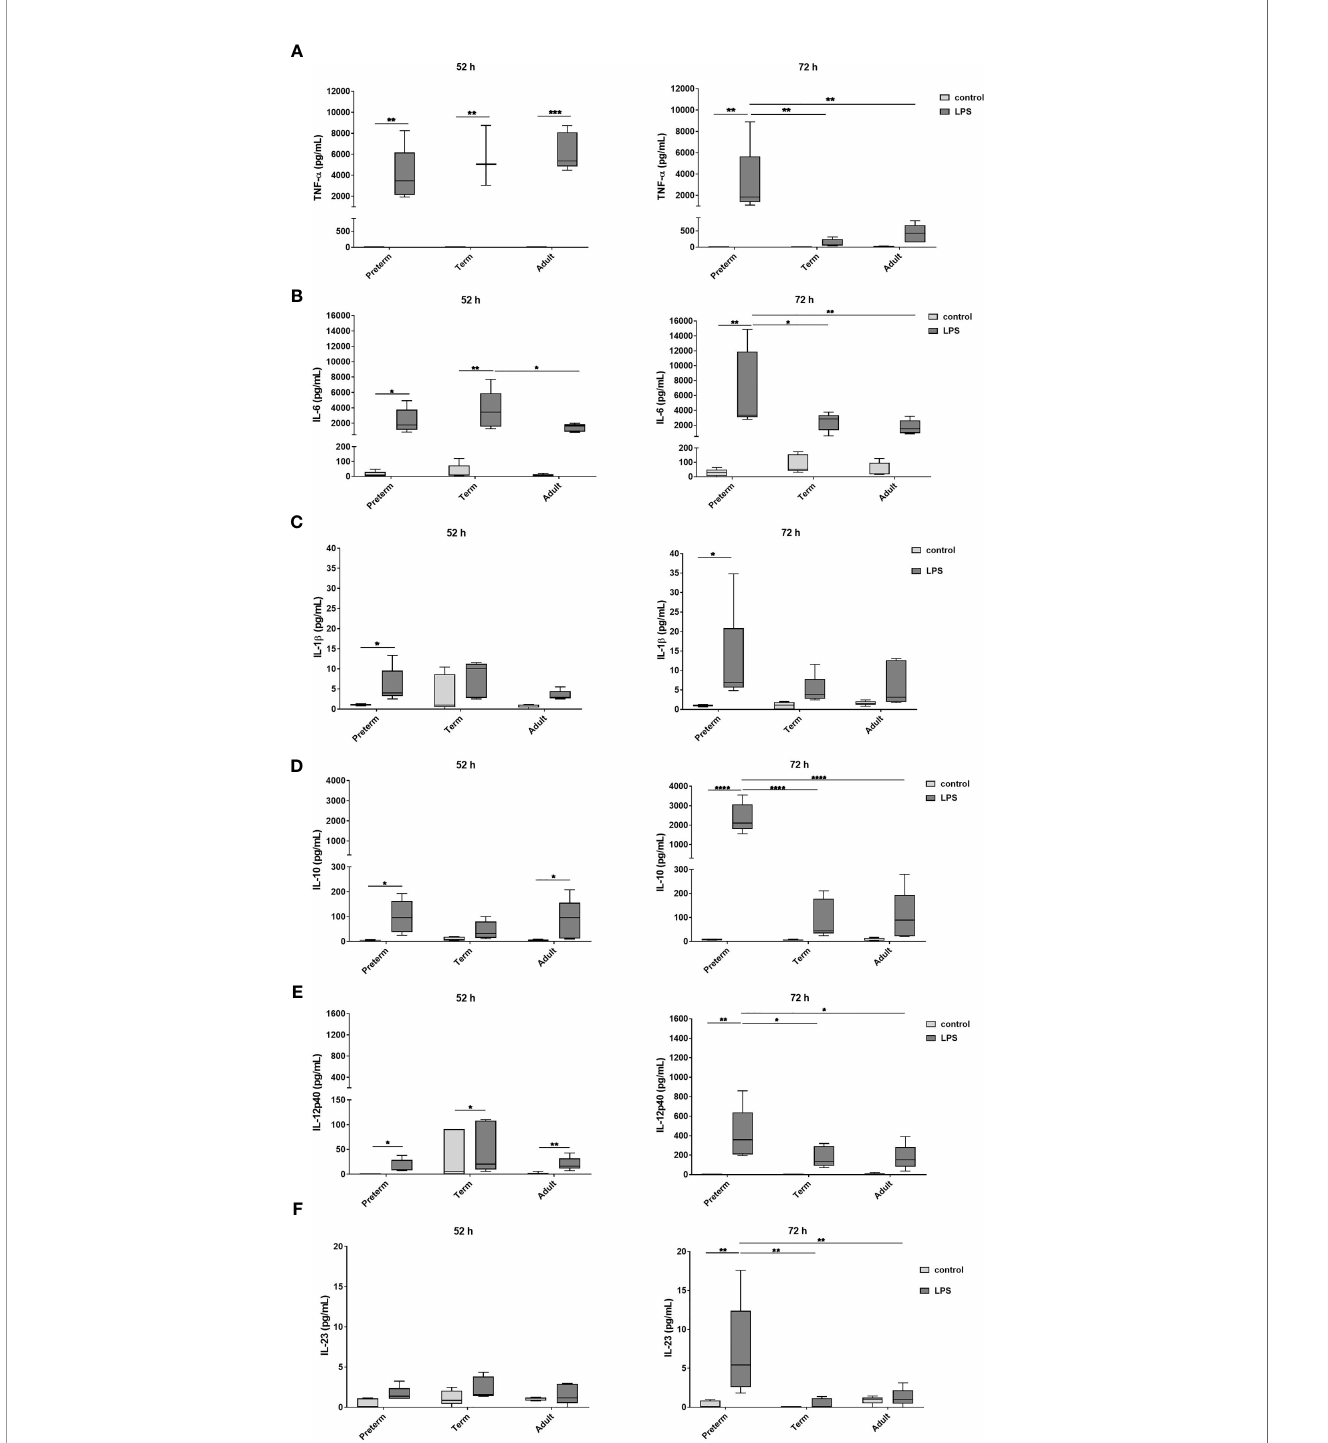
FIGURE 2 | Enhanced cytokine release after 72 h LPS stimulation in preterm macrophages (M Ф ) compared to term and adult M Ф . (A) TNF a , (B) IL-6, (C) IL-1 b , (D) IL-10, (E) IL-12p40, and (F) IL-23 release of LPS-stimulated M Ф measured in the supernatant after incubation for 52 h and 72 h (48 h 21% O 2 followed by 4 h or 24 h at 21% O 2 with or without LPS) using a cytokine bead array (n=5 independent experiments per time point with supernatants of up to ten different donors per group, box plots: median ± 25 th to 75 th percentiles and minimum to maximum, ANOVA followed by Holm-Sidak ’ s test, *p<0.05, **p<0.01, ***p<0.001, and